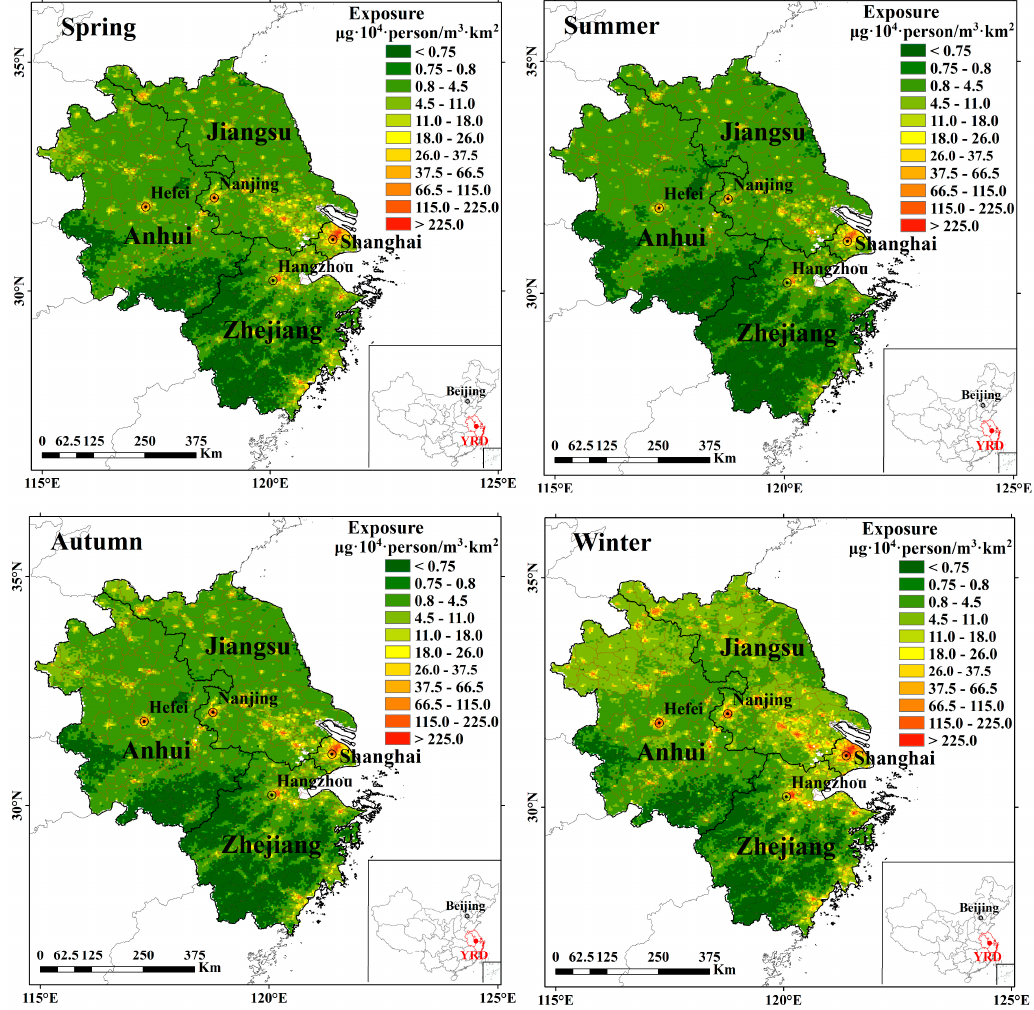
Figure 5. Spatial distribution of population-exposure intensity to PM 2.5 in the YRD region at 3-km resolution for the four seasons of 2013.